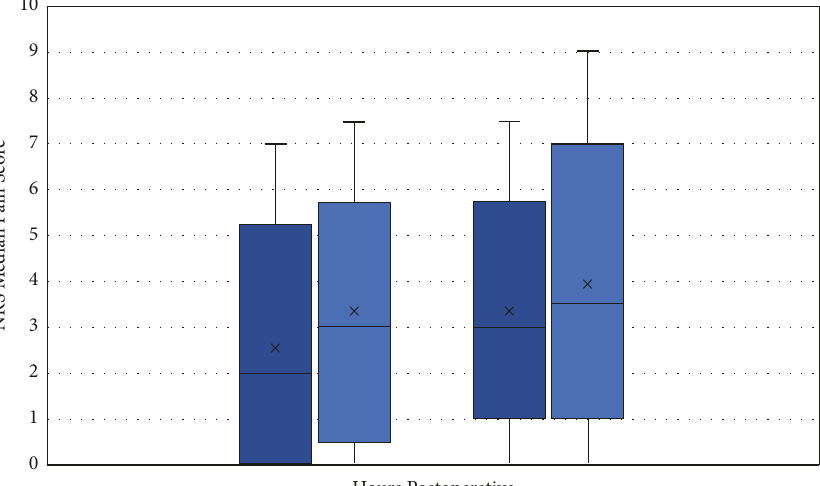
Figure 4: Postoperative pain